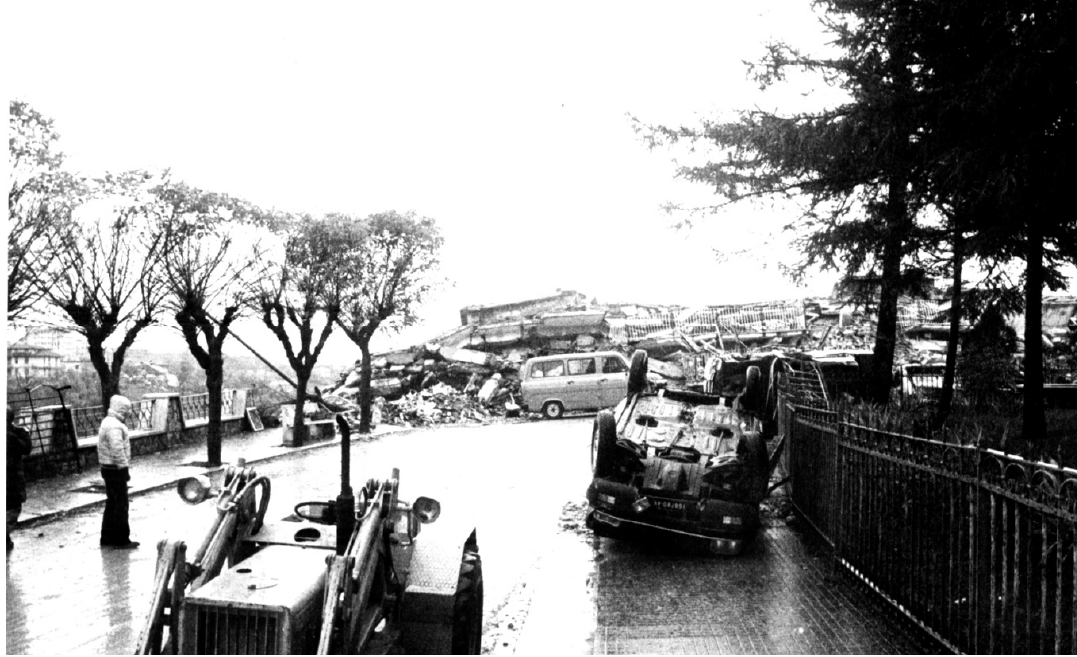
Figure 3. The earthquake in Sant’Angelo dei Lombardi. On the background, the “pancake effect” (Courtesy of Michele V.).